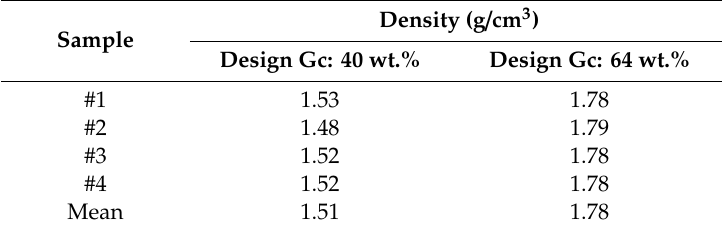
Table 8. Calculated Gc values of specimens measured using a hydrometer.